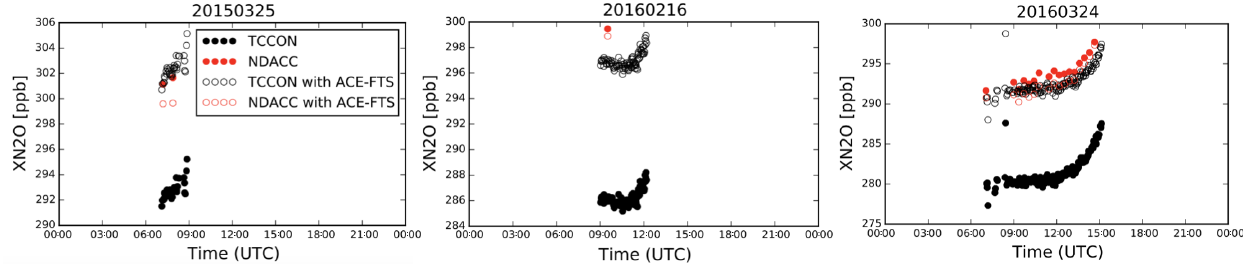
Figure 6. The standard TCCON- and NDACC-retrieved X N